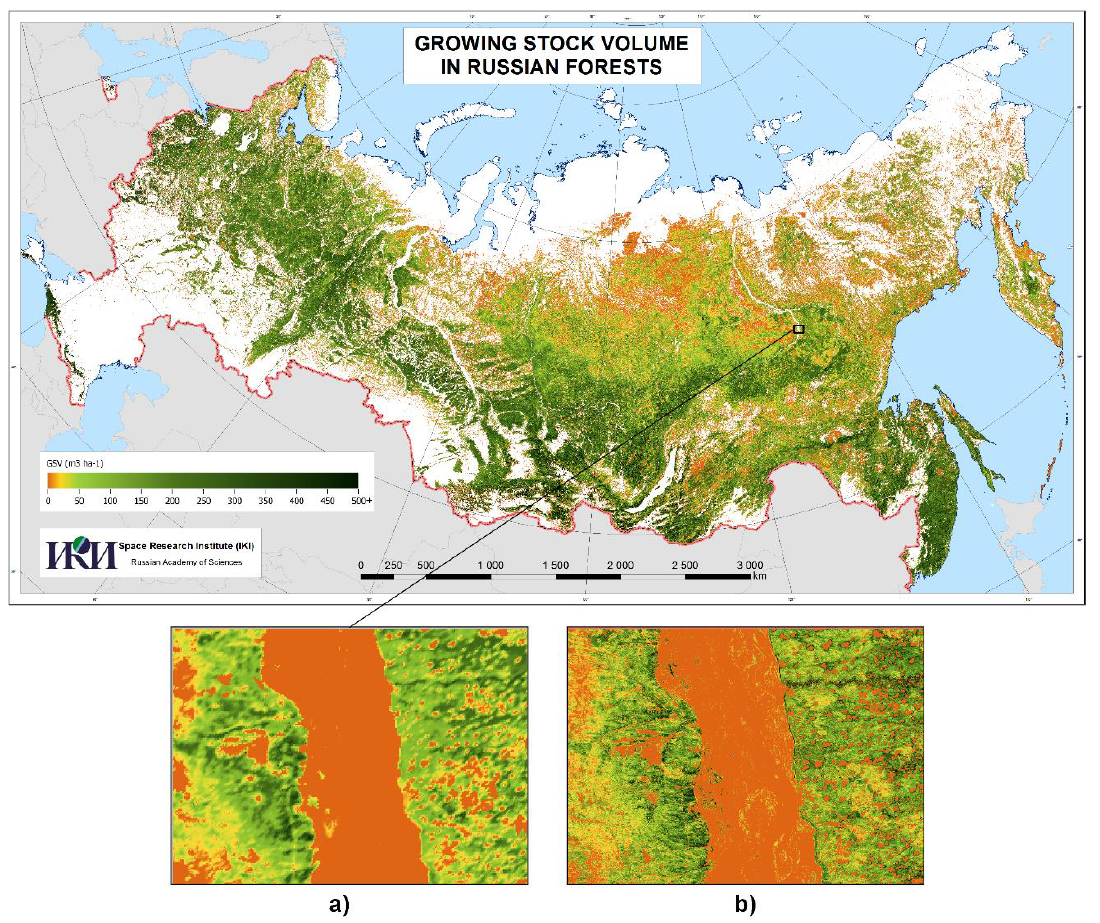
Figure 9. (Top) Russian forest GSV map at a spatial resolution of 230 m, based on winter MODIS data [73]; ( a ) extract from Sakha Republic; ( b ) corresponding extract using present methodology (same colour scale). The spatial resolutions of ( a ) and ( b ) are 230 and 10 m respectively.